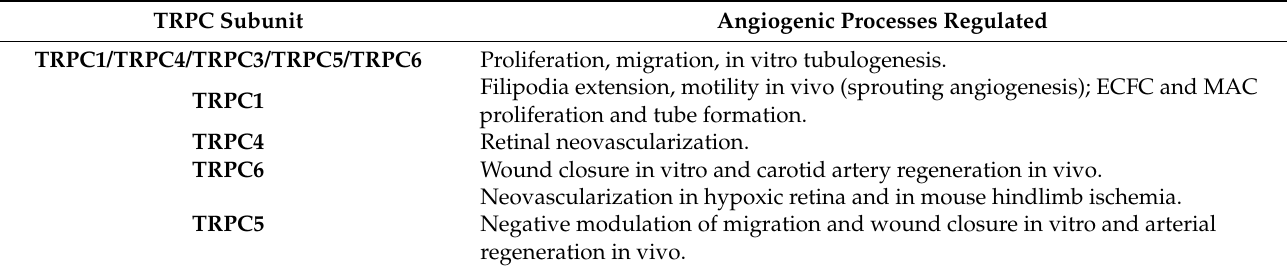
Table 1. Angiogenic processes regulated by TRPC subunits.